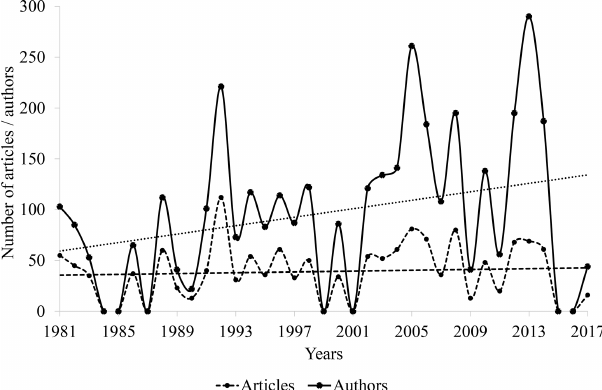
Figure 1. Dynamics of the number of participants in ICCE events: (a) – number of reports presented at the events; (b) – number of researchers who submitted as participants to the